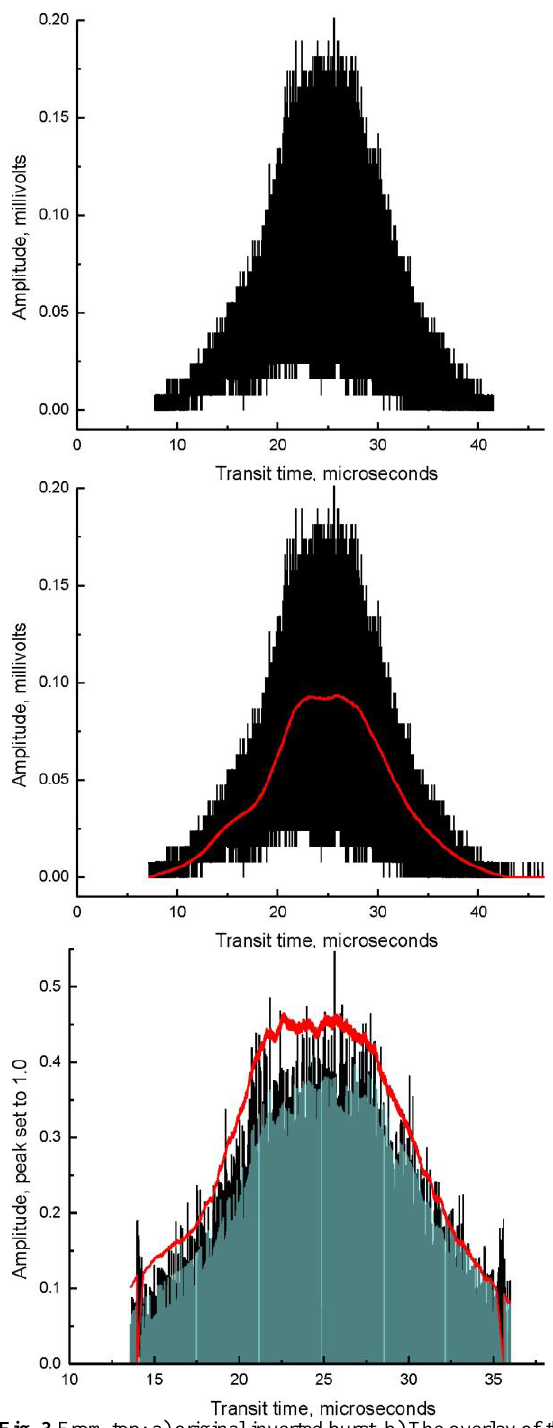
Fig. 3 From top: a) original inverted burst, b) The overlay of the pedestal on the signal burst, c) processed